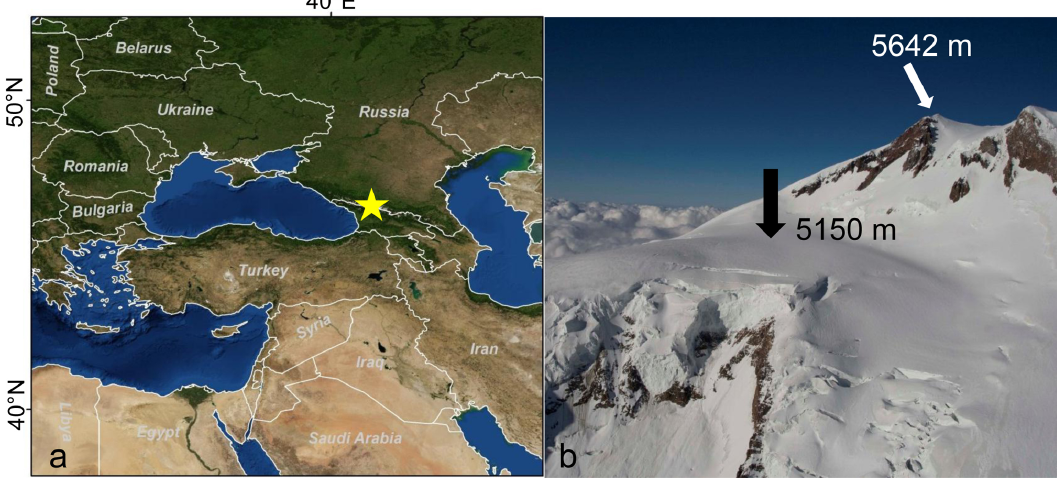
Fig. 1. (a) Location of study area and (b) snow sample collection and shallow core extraction site (indicated by the black arrow). The highest elevation (the West Elbrus summit) is indicated by the white